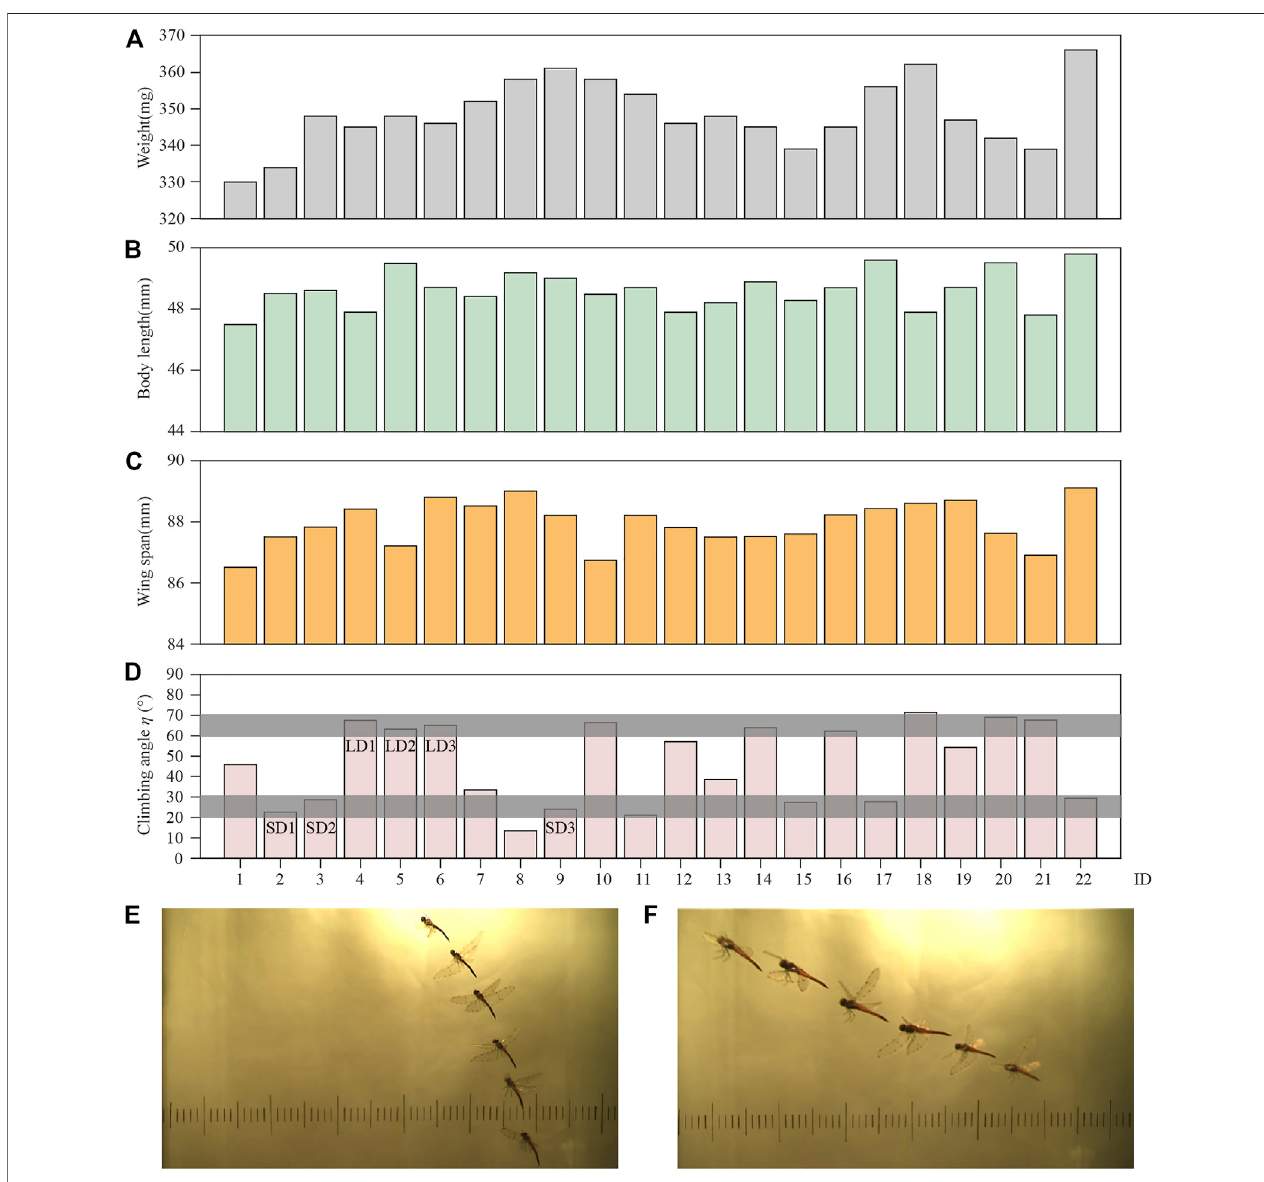
FIGURE 3 | Data of (A) weight; (B) body length; (C) wing span; (D) climbing angle; (E) body postures of LD1; and (F) body postures of